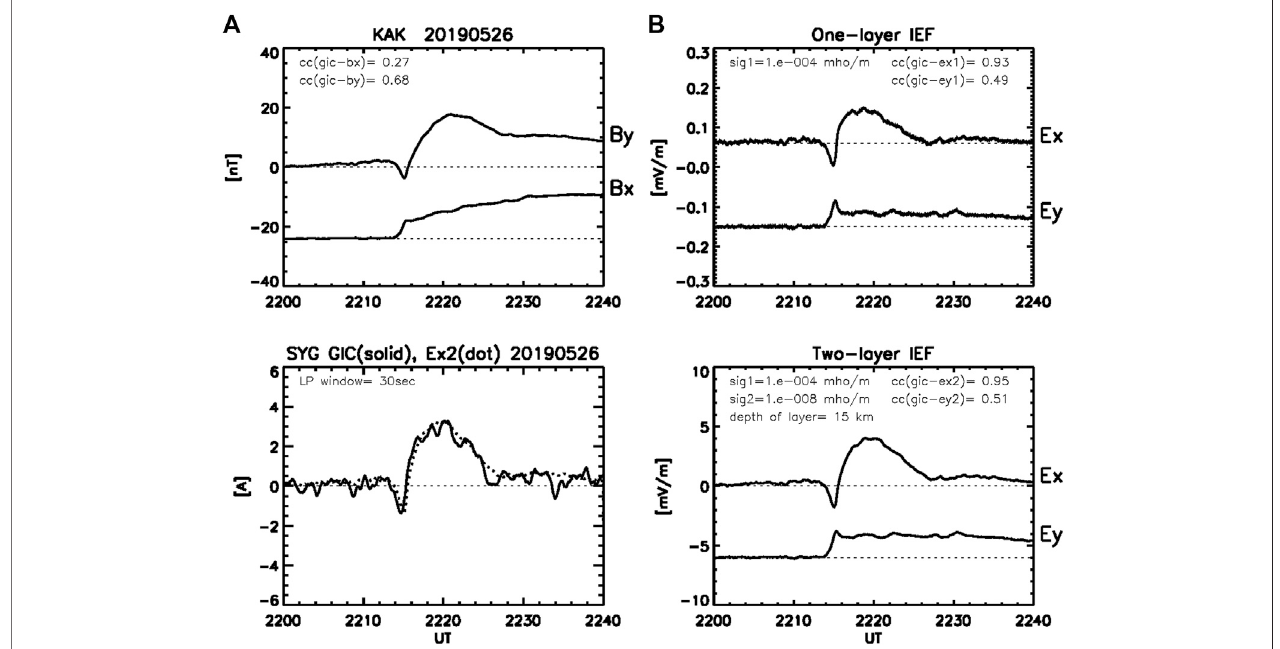
FIGURE13| Bx(dottedlines)andBy(solidlines)recordedduringtheSC event ( Figure 2 ) at Memambetsu (MMB, 35.7 ° GML), Kakioka (KAK, 27.8 ° GML),Okinawa(OKI,17.0 ° GML),andthemagneticde fl ectioncausedby the equatorial electrojet (EEJ) de fi ned as the difference between Bx (YAP, 0.5 ° GML) and Bx (OKI). All the stations are in the same local time zone (0630 MLT).